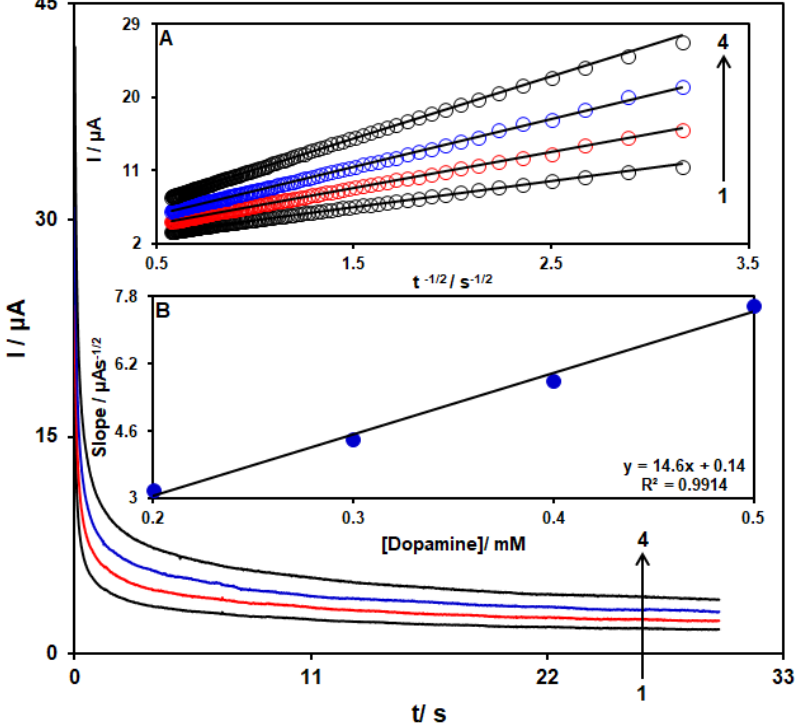
Figure 9. Chronoamperometric behavior of CoMOF-GO/1-M,3-BB/CPE in PBS (0.1 M; pH = 7.0) at potential of 170 mV for variable DA content. Insets: ( A ) plots of I vs. t − 1/2 and ( B ) plots of the slopes from the straight lines vs. DA level ( 1–4 : 0.2, 0.3, 0.4, and 0.5 mM).